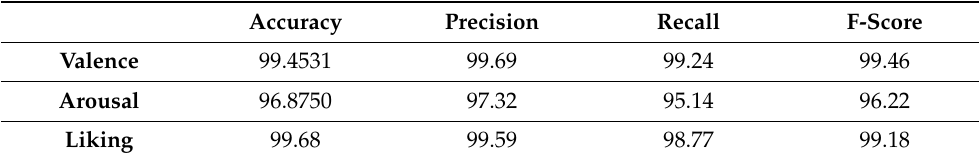
Table 9. Results of the proposed